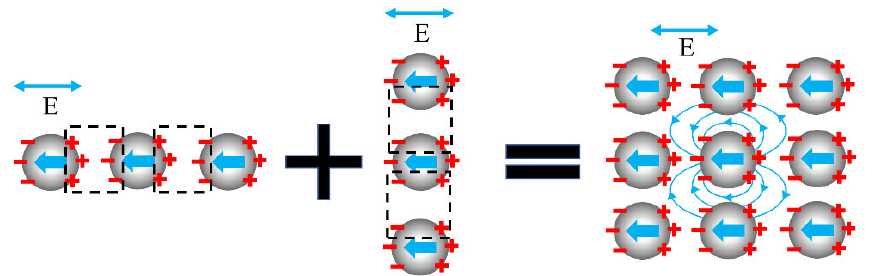
Figure 2. The absorption and scattering efficiencies of the 3 3 square array of Ag nanoparticles at different particle spacing with radius 14 R